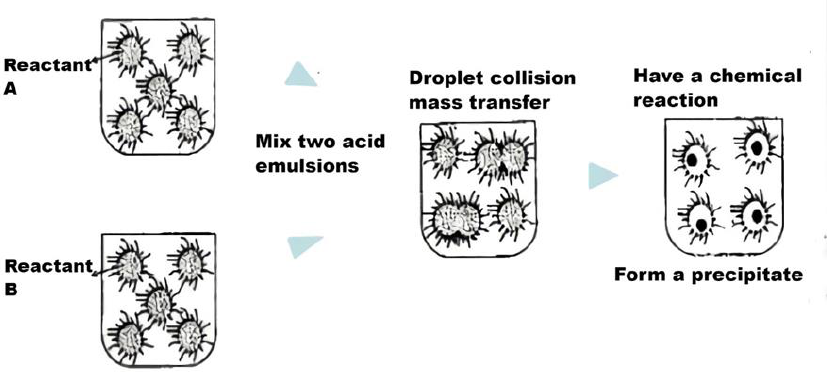
Figure 12. Flow chart of microemulsion method.